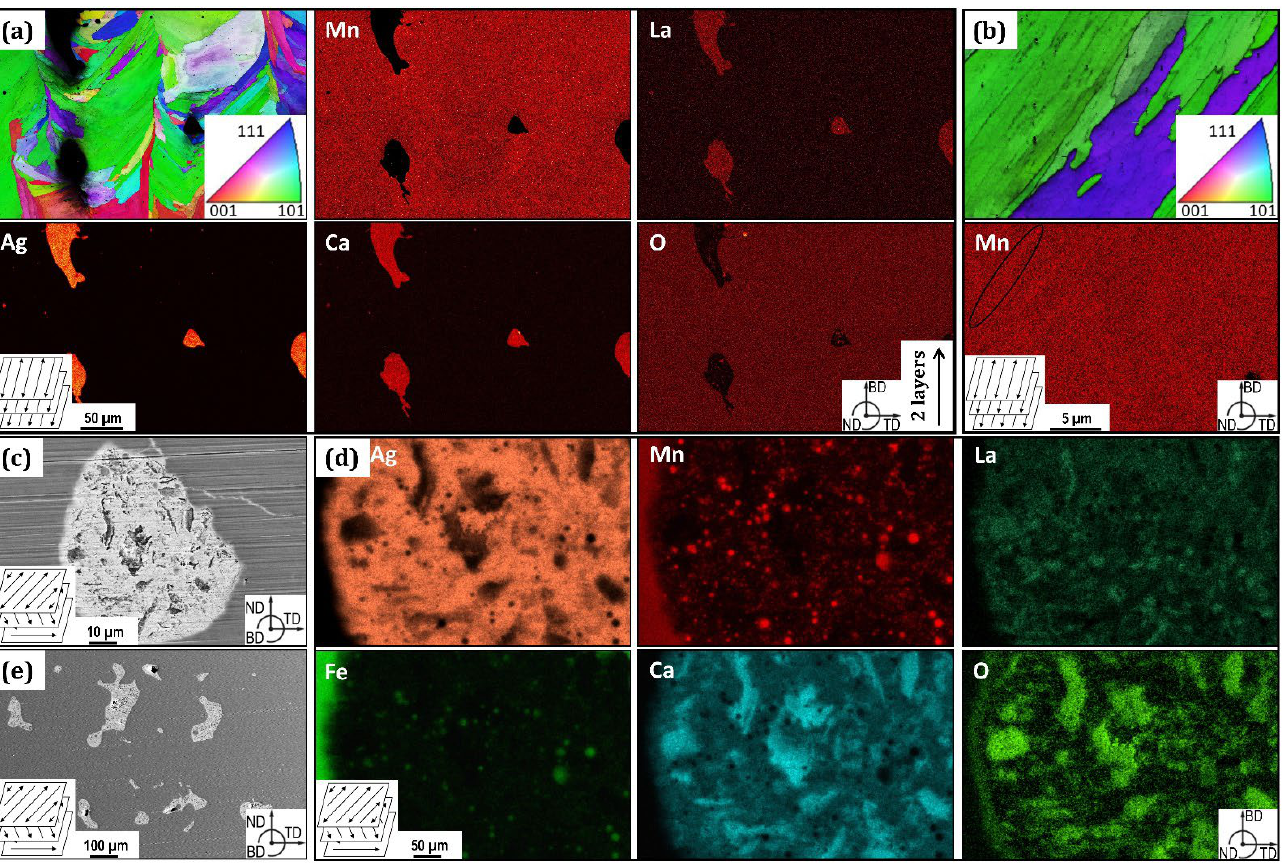
Figure 6. Microstructure of the FeMn matrix and AgCaLa phases: ( a ) SEM-EBSD with corresponding SEM-EDS: HD, austenitic matrix with AgCaLa phases; ( b ) SEM-EBSD with corresponding SEM-EDS: HD, columnar dendritic structure with segregations; ( c , e ) SEM-SE: HD, water-free prepared AgCaLa phases in the FeMn matrix; ( d ) SEM-EDS: HD, water-free prepared inhomogeneous distribution of alloying elements and O in an AgCaLa phase.